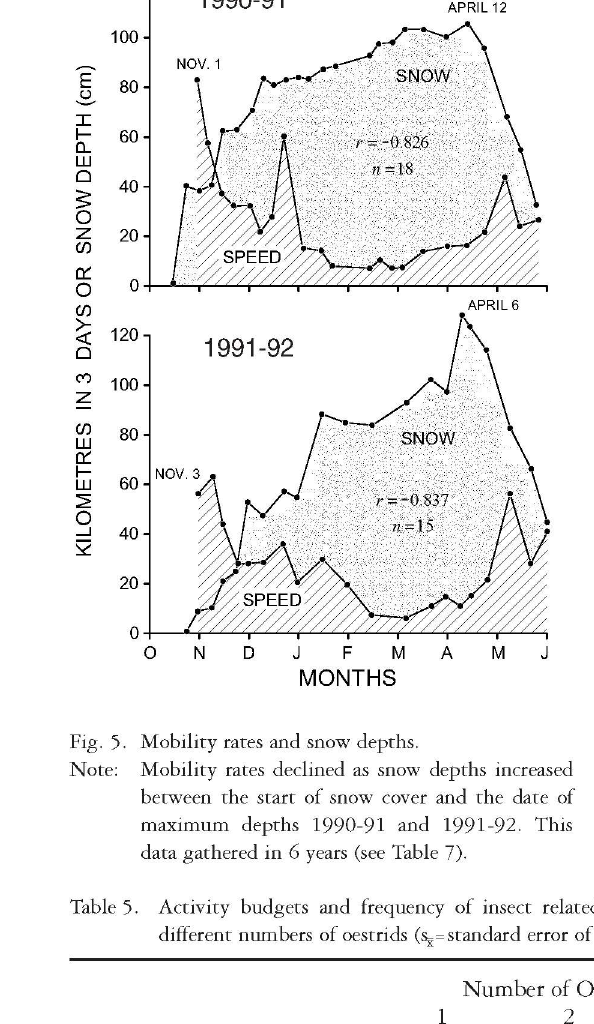
Table 5. Activity budgets and frequency of insect related activity during attack of different numbers of oestrids (s x =standard error of the